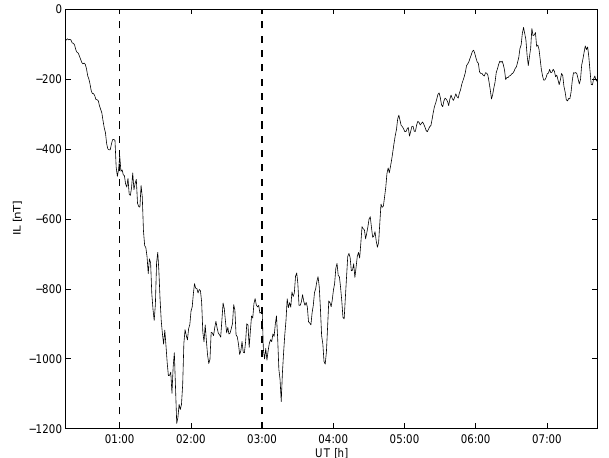
Fig. 2. The local variant of AL , IL index computed from the mea- sured IMAGE magnetometer array data for 26 June 1998. The dashed lines indicate 01:00 UT and 03:00 UT,